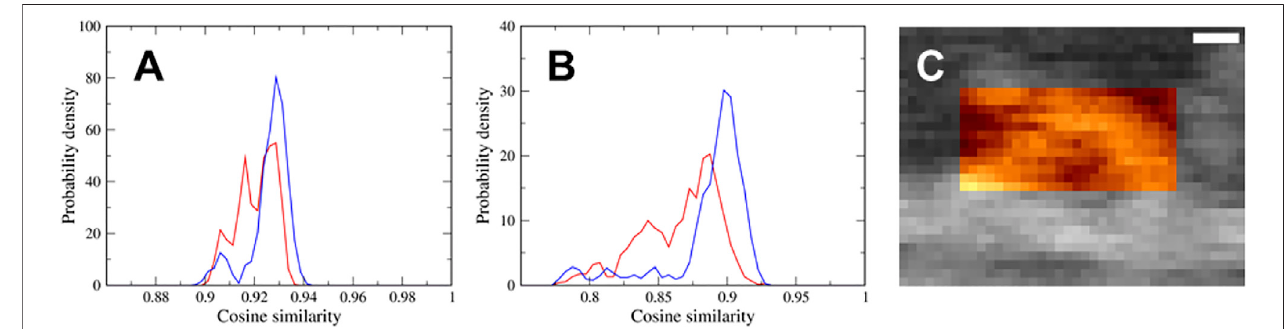
FIGURE4|(A,B) Probabilitydensitydistributionsofthecosinesimilarityofpseudo-AFMimagesusing (A) theregionof40×30pixelsusedforthe fl exible fi ttingand (B) the region of 25 × 12 pixels corresponding to the myosin neck. The distributions of the down-up state and the down-down state are shown in red and blue, respectively. (C) The region of AFM image corresponding to the myosin neck is shown in color. Scale bar, 10